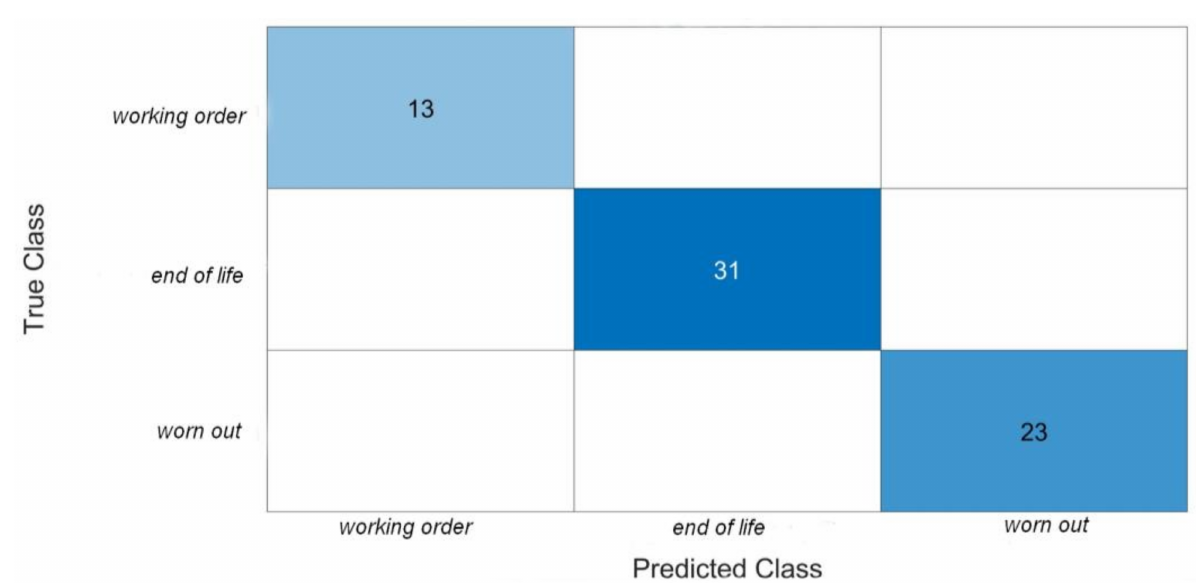
Figure 10. Matrix for classifying the wear state of the pump on the basis of features obtained from vibration signals.